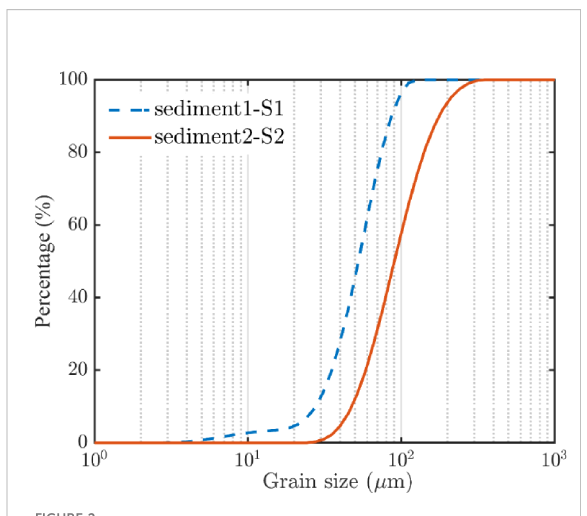
FIGURE 2 The particle size distributions of the two bed